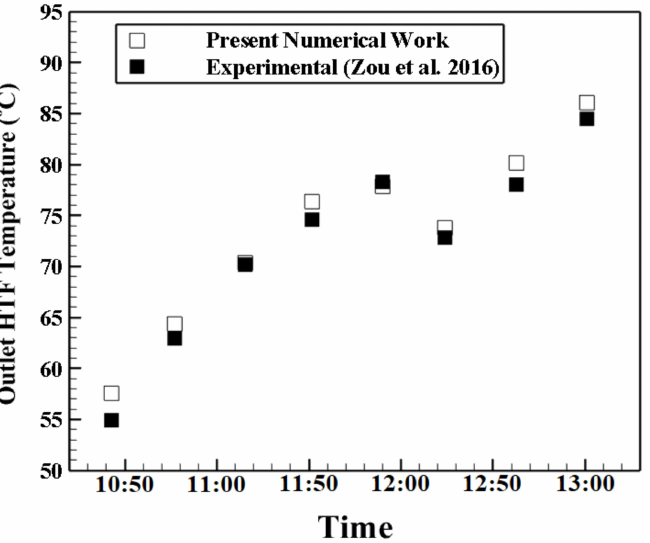
Figure 6. Results of the validation analysis between the present numerical work and experimental work of Zou et al.